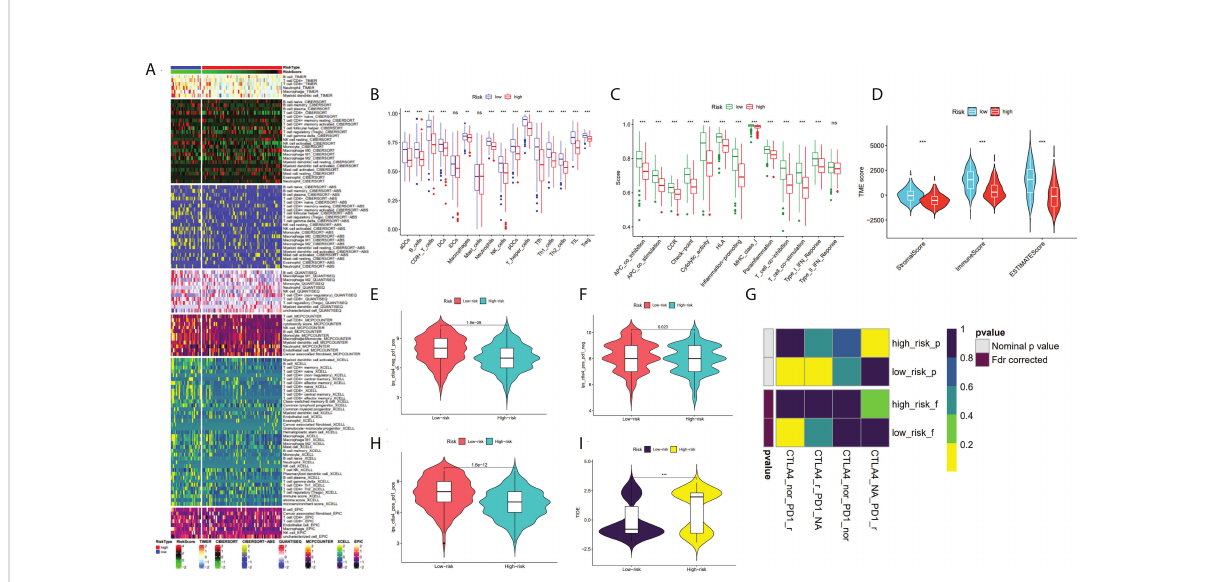
FIGURE 8 Analysis of TME and immunotherapy among the high- and low-risk groups with SKCM patients. (A) Heatmap for immune in fi ltration based on QUANTISEQ, TIMER, CIBERSORT-ABS, CIBERSORT, XCELL, MCP-counter, and EPIC algorithms among high- and low-risk groups. (B, C) Based on the ssGSEA algorithm, the box plots illustrated the variation in immune cell in fi ltration and immune function among the low- and high-risk groups of SKCM patients. (D) Comparison of the immune, stromal and ESTIMATE scores between the low- and high-risk groups, respectively. (E, F, H) The distribution of IPS in the high-risk and low-risk groups in TCGA dataset. (I) The TIDE score between two risk subgroups. (G) SubMap analysis manifested that the low-risk group was more sensitive to the anti-PD-1 therapy. (*P < 0.05, **P < 0.01, ***P < 0.001 and ns = not signi fi